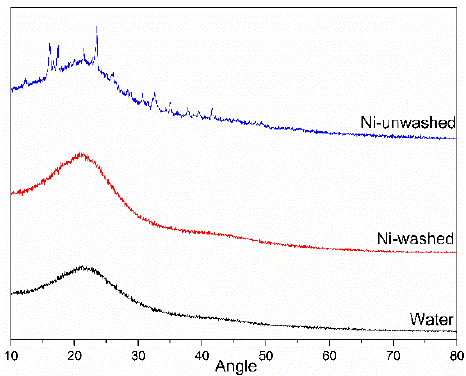
Figure 2. The X-ray diffraction (XRD) spectra of pretreated organsolv